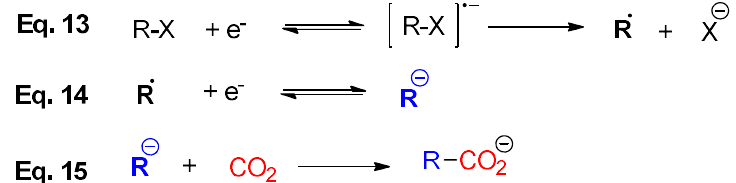
Table 3. Viscosities and coefficient diffusion values of DMF and EMIM TFSI. Entry